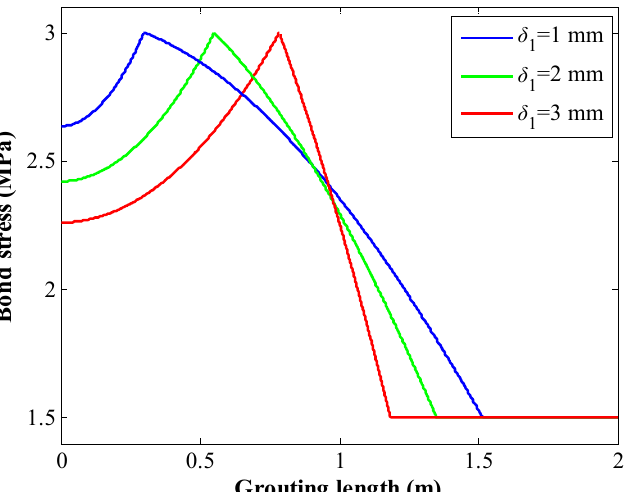
Figure 16. Effect of the bond slip in the bond strength on the bond stress distribution of the boundary surface.